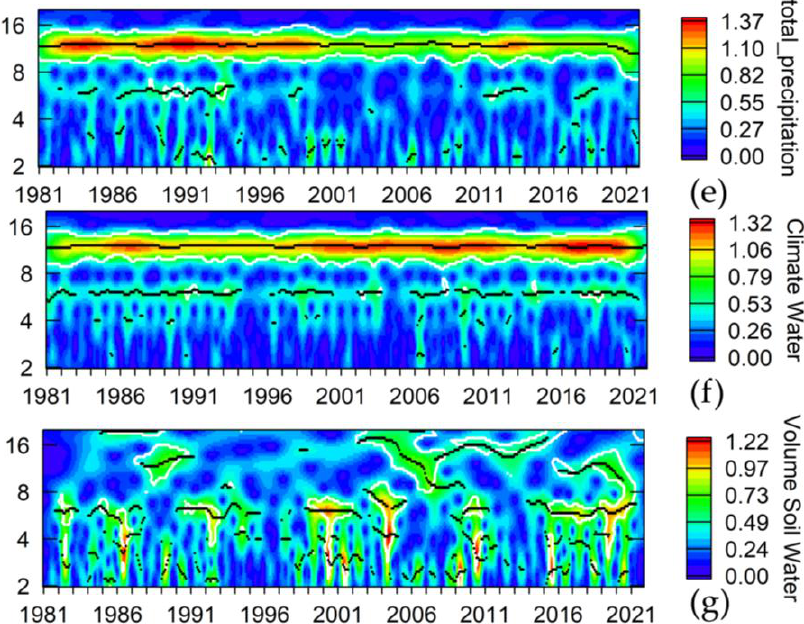
Figure 13. Morlet wavelet transformations of climate conditions.